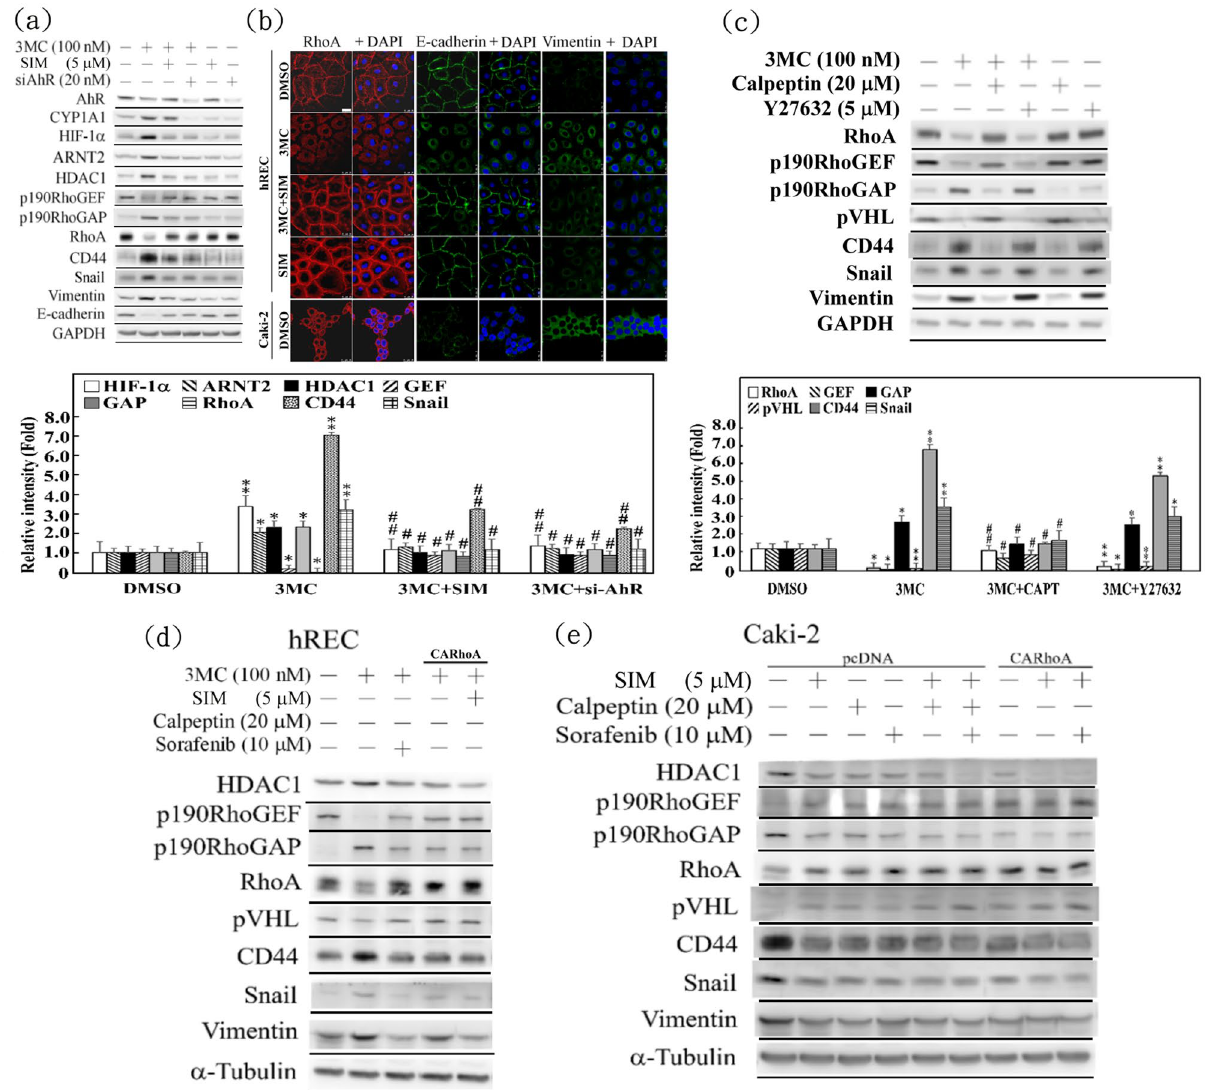
Figure 1. An essential role of RhoA in 3MC-mediated hREC carcinogenesis, in part, through an AhR- dependent mechanism. Cells were transfected with siAhR overnight or pretreated with simvastatin for 1 h, followed by a 3-h 3MC challenge, and the resulting cells were subjected to Western blot analysis ( a ) and immunofluorescence staining ( b ) for the indicated molecules. Scale bar = 25 μm. ( c ) Cells were pretreated with calpeptin and Y27632 (a ROCK inhibitor) for 1 h, followed by 3-h 3MC treatment, and the resulting cell lysates were analyzed by Western blots, with GAPDH used as an internal control. ( d ) hRECs were transfected with CARhoA overnight, and pretreated with calpeptin for 1 h or sorafenib for 5 h, followed by 3MC challenge for 3 h. Western blot analysis of the indicated proteins were carried out to compare the effects of CARhoA overexpression, simvastatin and calpeptin with sorafenib in hREC carcinogenesis caused by 3MC. ( e ) Caki-2 cells were transfected with empty or CARhoA overexpression vector overnight, followed by 1 h of simvastatin and calpeptin, or 5 h of sorafenib treatment. Western blot analysis of the EMT and hypoxia markers was carried out to evaluate the synergistic effects of the combination treatment of simvastatin, CARhoA overexpression (or calpeptin), and sorafenib in alleviating RCC progression. The bar chart and Table S3 show the normalized intensity of each protein band obtained using GAPDH or α -tubulin in Western blots. (*P < 0.05 and **P < 0.01 vs. control; # P < 0.05 and ## P < 0.01 vs. 3MC treatment alone). The gels have been run in the same experimental conditions and the cropped blots were shown. The entire gel pictures were shown in the Supplemental Fig.